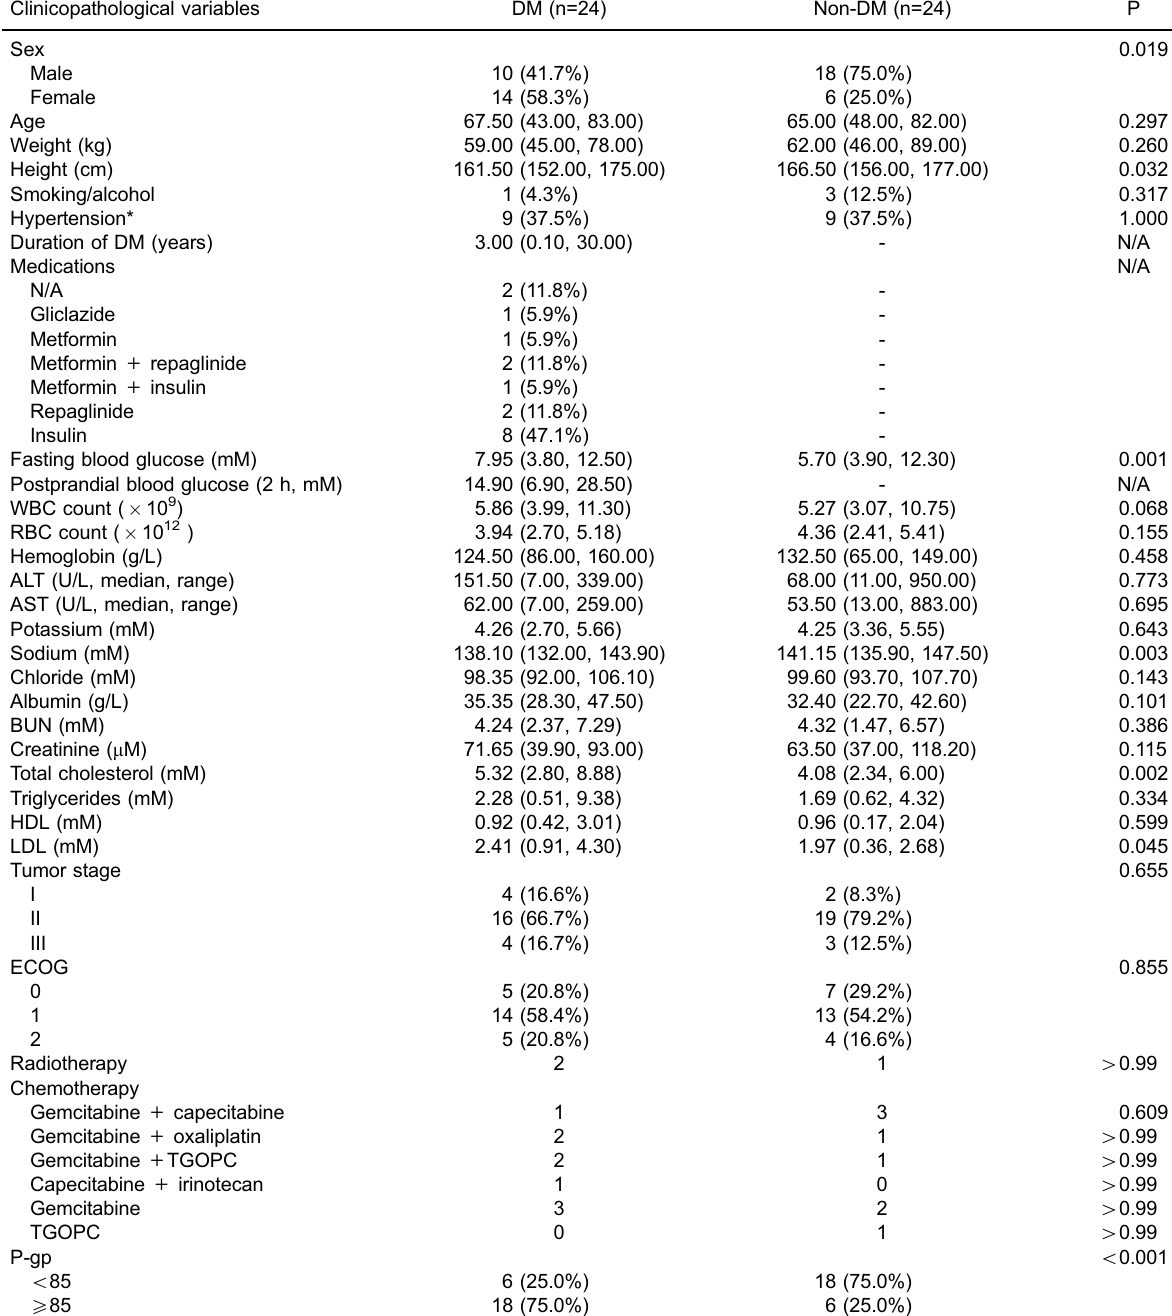
Table 1. Clinicopathological characteristics of patients with pancreatic cancer with or without diabetes mellitus (DM). Clinicopathological